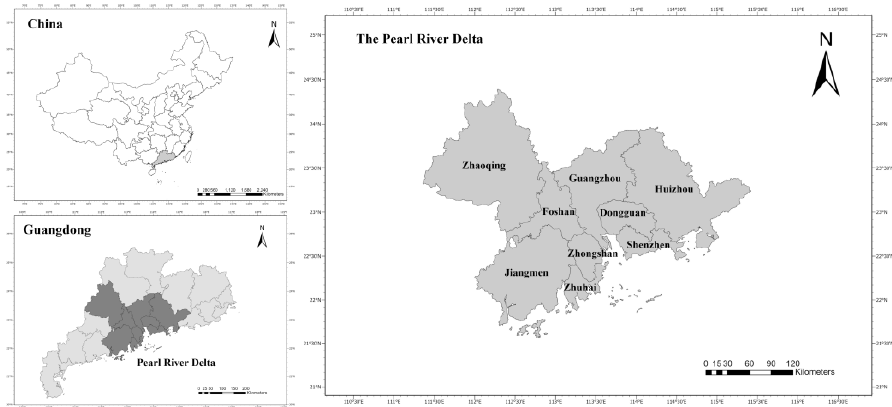
Figure 2. The location of the Pearl River Delta urban agglomeration.